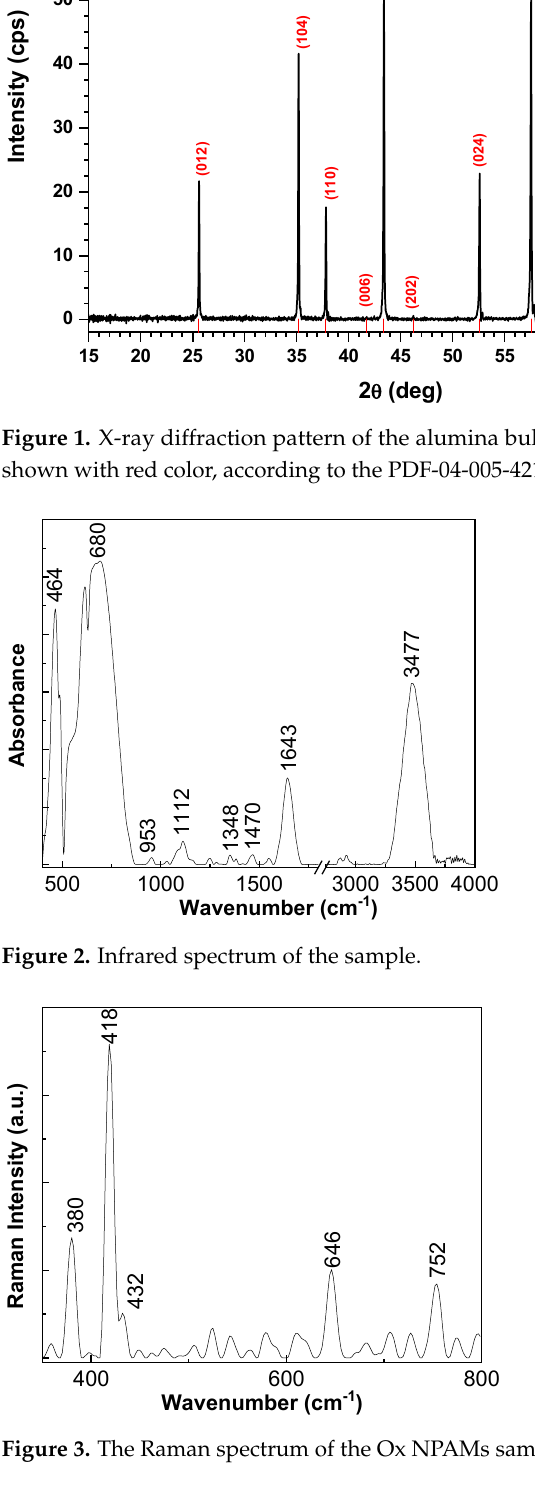
Figure 1. X-ray diffraction pattern of the alumina bulk sample and the diffraction lines’ positions, shown with red color, according to the PDF-04-005-4213 reference file.